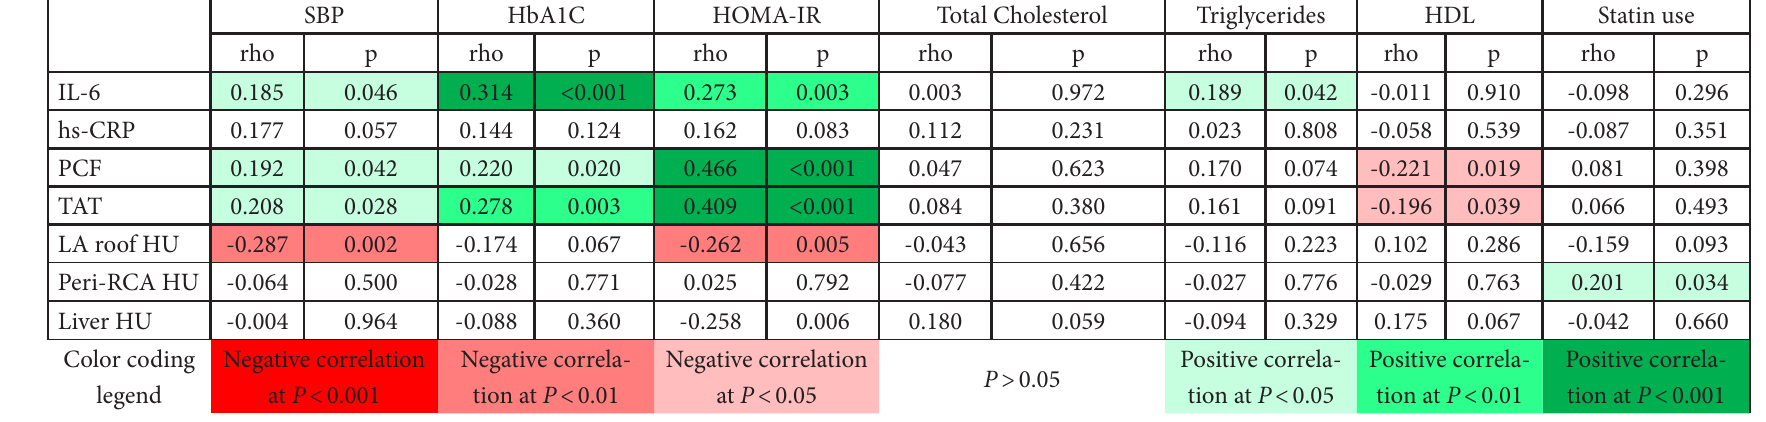
Table 2. Correlation of Inflammation Markers and Ectopic Fat Measures with Markers of Cardiometabolic